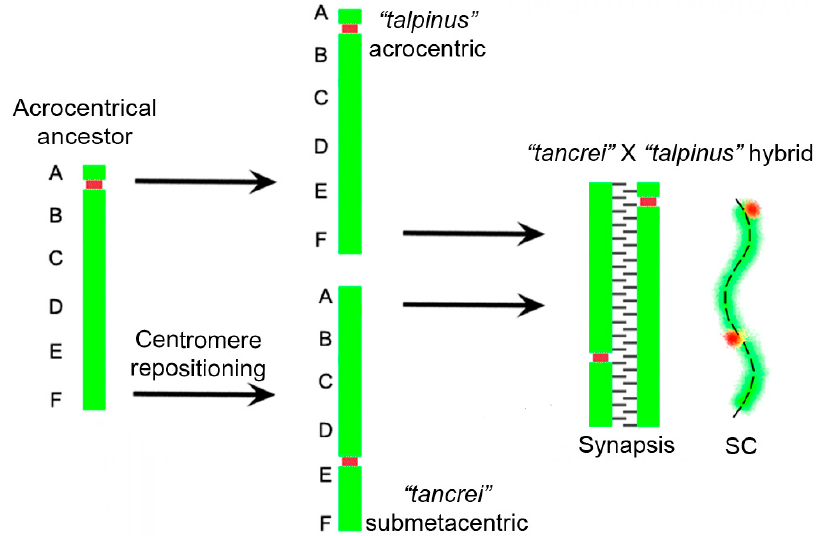
Figure 5. Hypothetical events of chromosome evolution in Ellobius. The scheme explains the evolutionary transformation of the ancestral acrocentric into a submetacentric that was inherited by all chromosomal forms of the E. tancrei . The synaptic structure at the right is based on the SC structure of the interspecific F1 hybrids of E. talpinus (2n = 54, NF = 54) and E. tancrei (2n = 54, NF = 56 or 2n = 34, NF = 56; etc.). The red dots indicate centromeres.